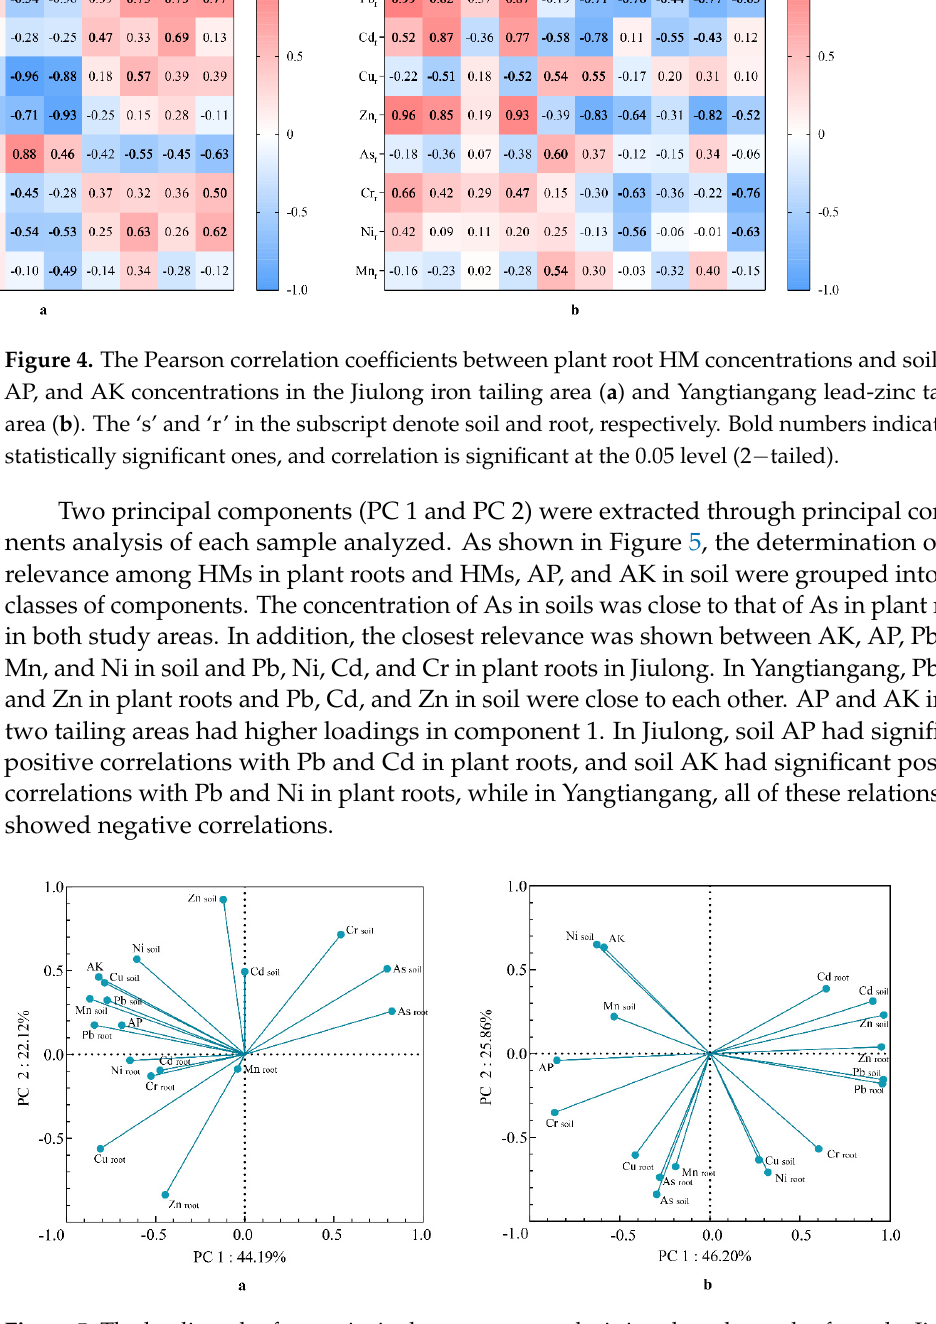
Figure 5. The loading plot from principal component analysis in selected samples from the Jiulong iron tailing area ( a ) and Yangtiangang lead − zinc tailing area ( b